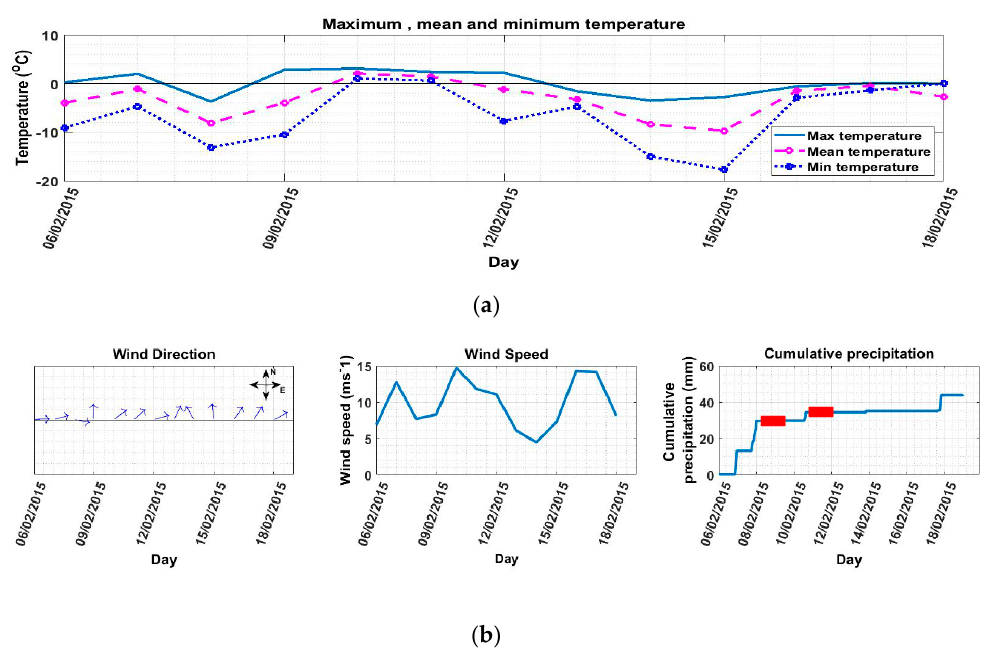
Figure 4. Weather information recorded by the Kemi_Ajos weather station located at 65° 40' 23.48" N and 24° 30' 54.72" E during the experiment: ( a ) mean, minimum and maximum temperature information; and ( b ) wind direction, wind speed and cumulative precipitation information. The red squares in precipitation subfigure represent missing data.